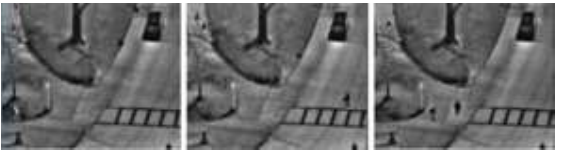
Figure 16. Selecting three images randomly as main images.